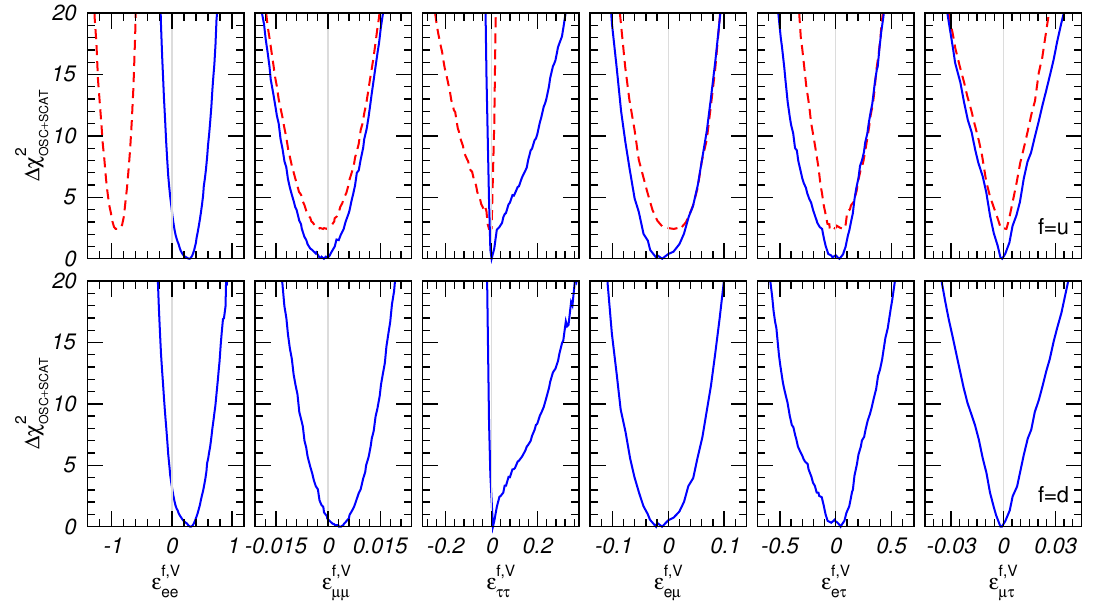
Figure 4 . Dependence of the (cid:1) (cid:31) 2 on the NSI parameters (cid:15) q;V for q = u (upper panels) OSC+SCAT (cid:11)(cid:12) and q = d (lower panels), for both LMA (solid) and LMA-D (dashed) regions from the combined analysis of global oscillation and CHARM + NuTeV scattering data. These results correspond to the current limits assuming heavy NSI